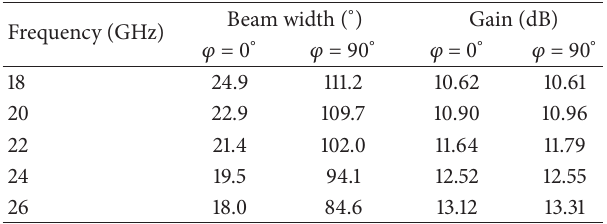
Table 3: Beam width and gain of the IMF-CBSA array without feeding network obtained in the